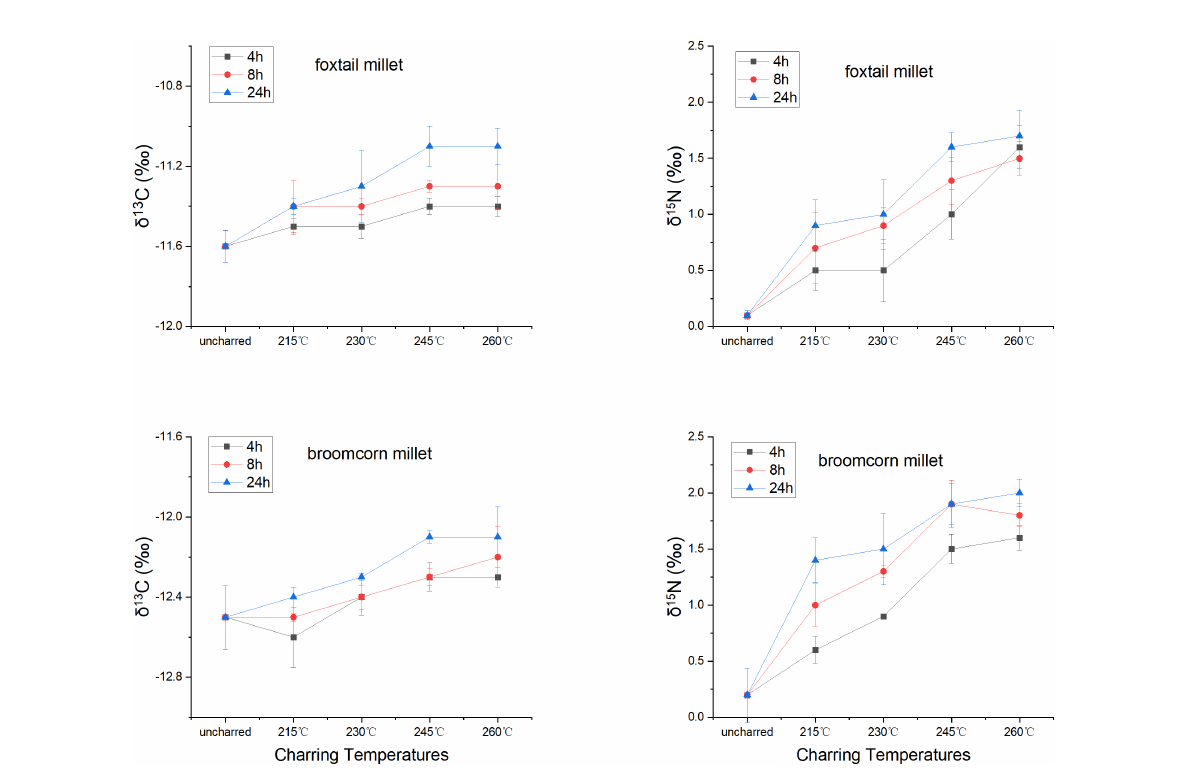
FIGURE 3 The change of carbon and nitrogen isotope values of foxtail ( Setaria italica ) and broomcorn millet ( Panicum miliaceum ) grains when heated at different temperatures and